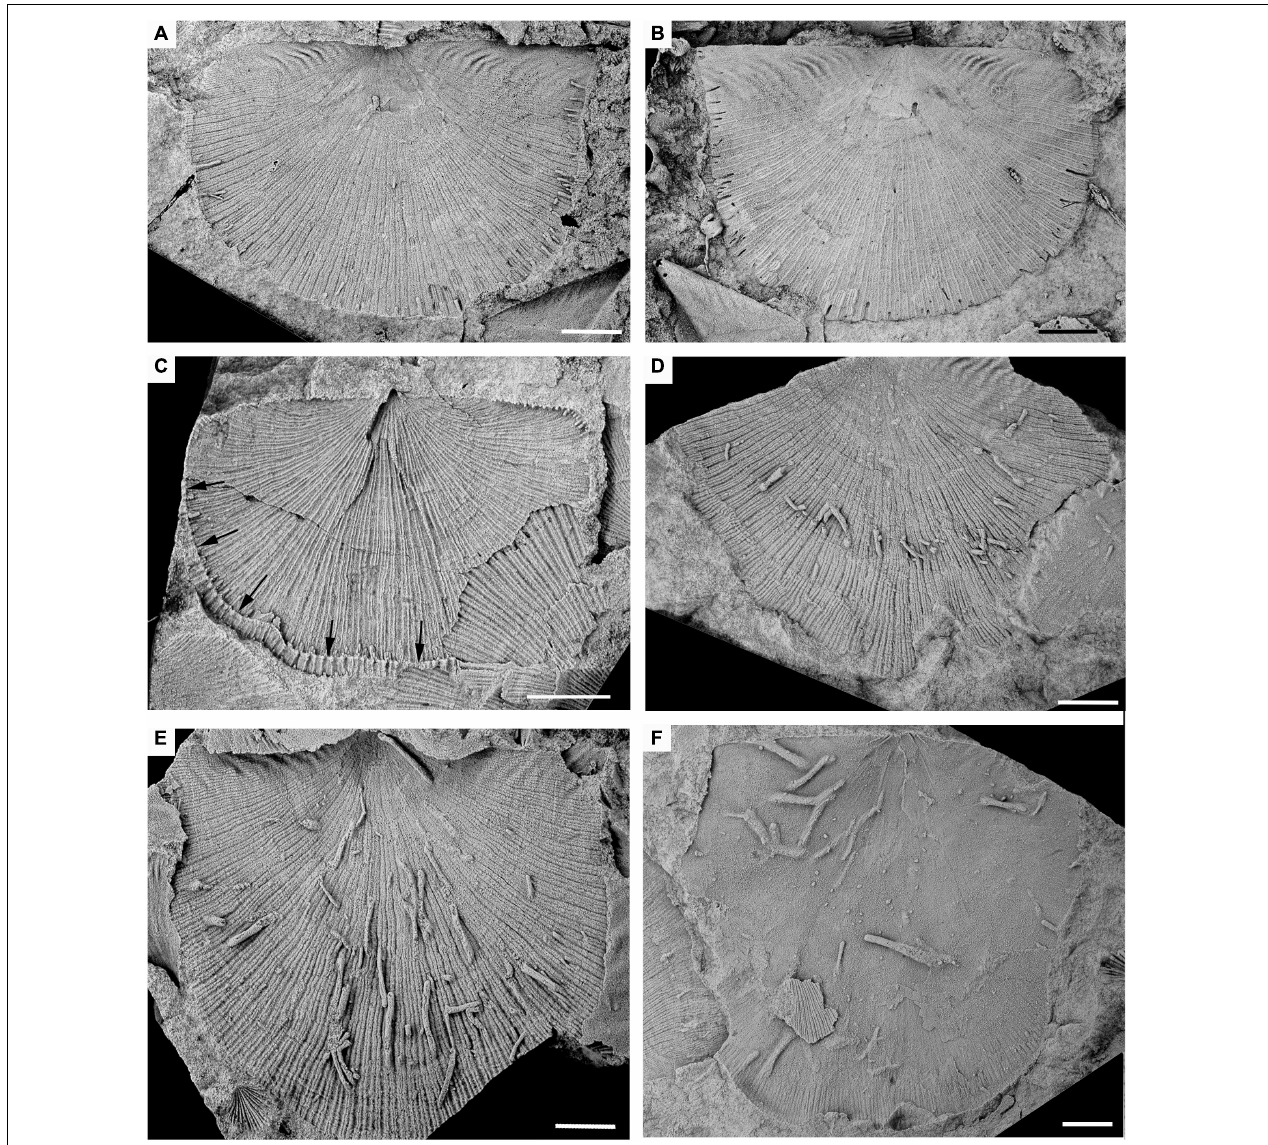
FIGURE 3 | (A–F) Valves of the two brachiopod species recorded in the assemblage hosting Palaeosabella (all scale bars = 5 mm). (A) External mould (A) and latex cast of exterior. (B) Of ventral valve of Colaptomena expansa with borings arranged on valve margins (CPI 6504a). (C) External mould of dorsal valve of Heterorthis retrorsistria with borings arranged on a growth line (CPI 6504b). (D) External mould of ventral valve of Colaptomena expansa with borings randomly arranged throughout the valve surface (CPI-10002). (E) External mould of ventral valve of Colaptomena expansa with borings arranged on a growth line (CPI-10004). (F) Internal mould of ventral valve of Colaptomena expansa with borings disorganised on valve internal surface